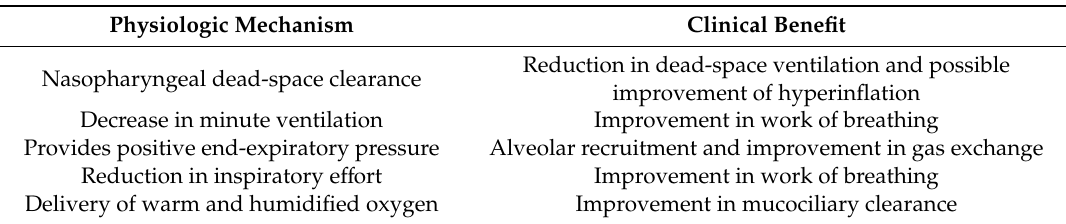
Table 1. Summary of the physiologic mechanisms and the resulting clinical benefits of high-flow nasal therapy (HFNT) in stable chronic obstructive pulmonary disease (COPD)